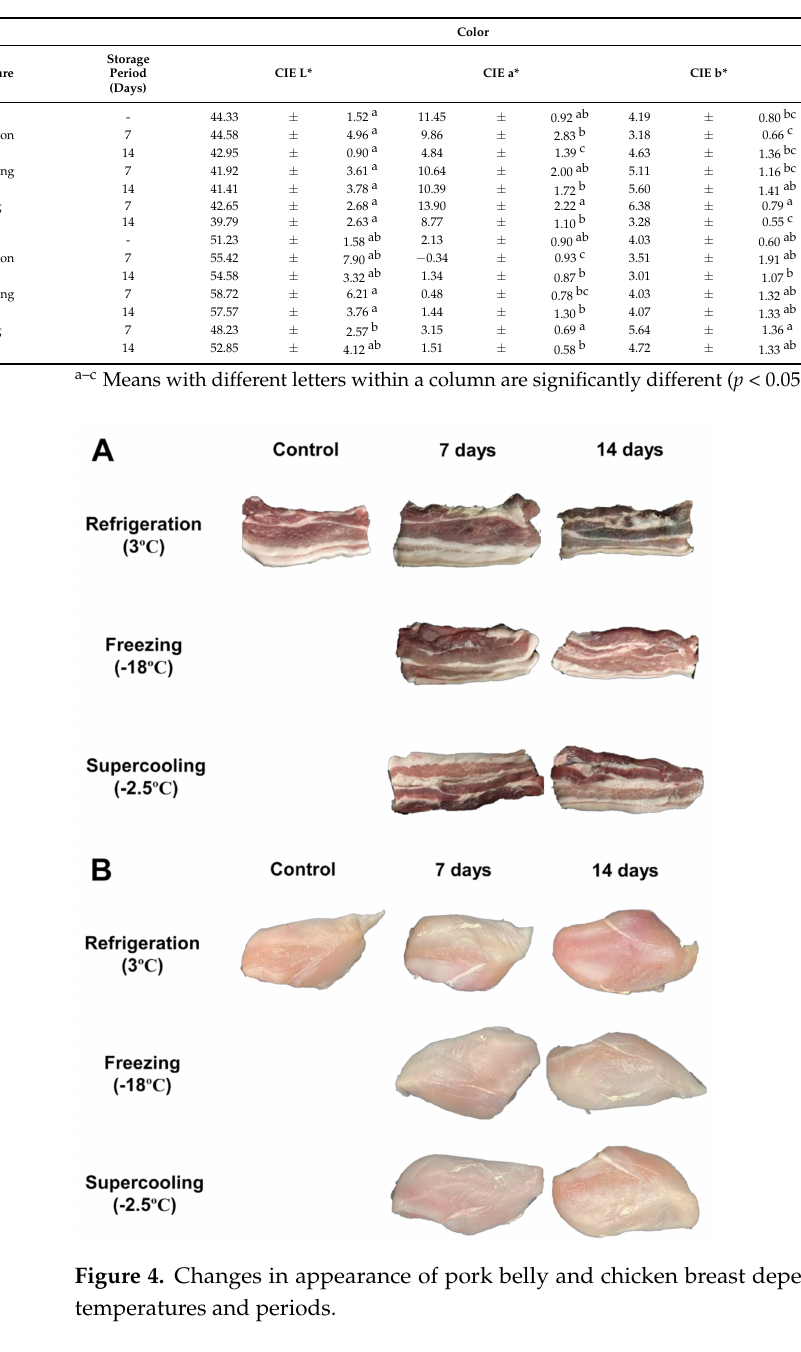
Table 1. Changes in the color of pork belly and chicken breast depending on various storage temperatures and periods.